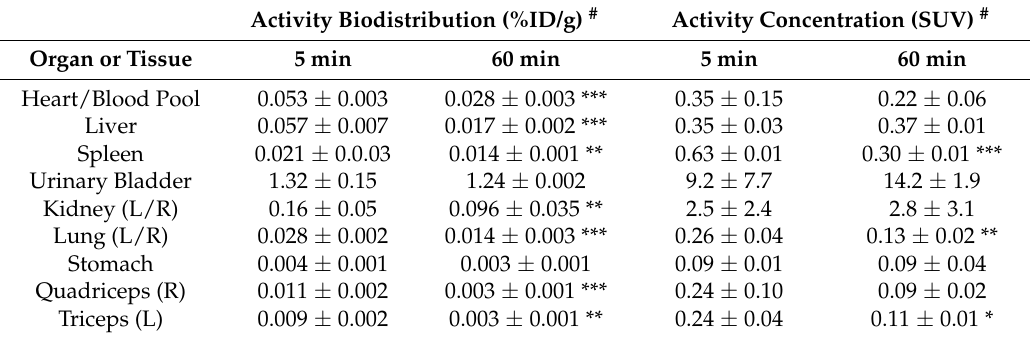
Table 1. Organ and tissue biodistribution (%ID/g) and concentration (SUV) of 68 Ga-DOTA-TBIA101 in healthy New Zealand White rabbits (NZR1). Activity Biodistribution (%ID/g) # Activity Concentration (SUV) # Organ or